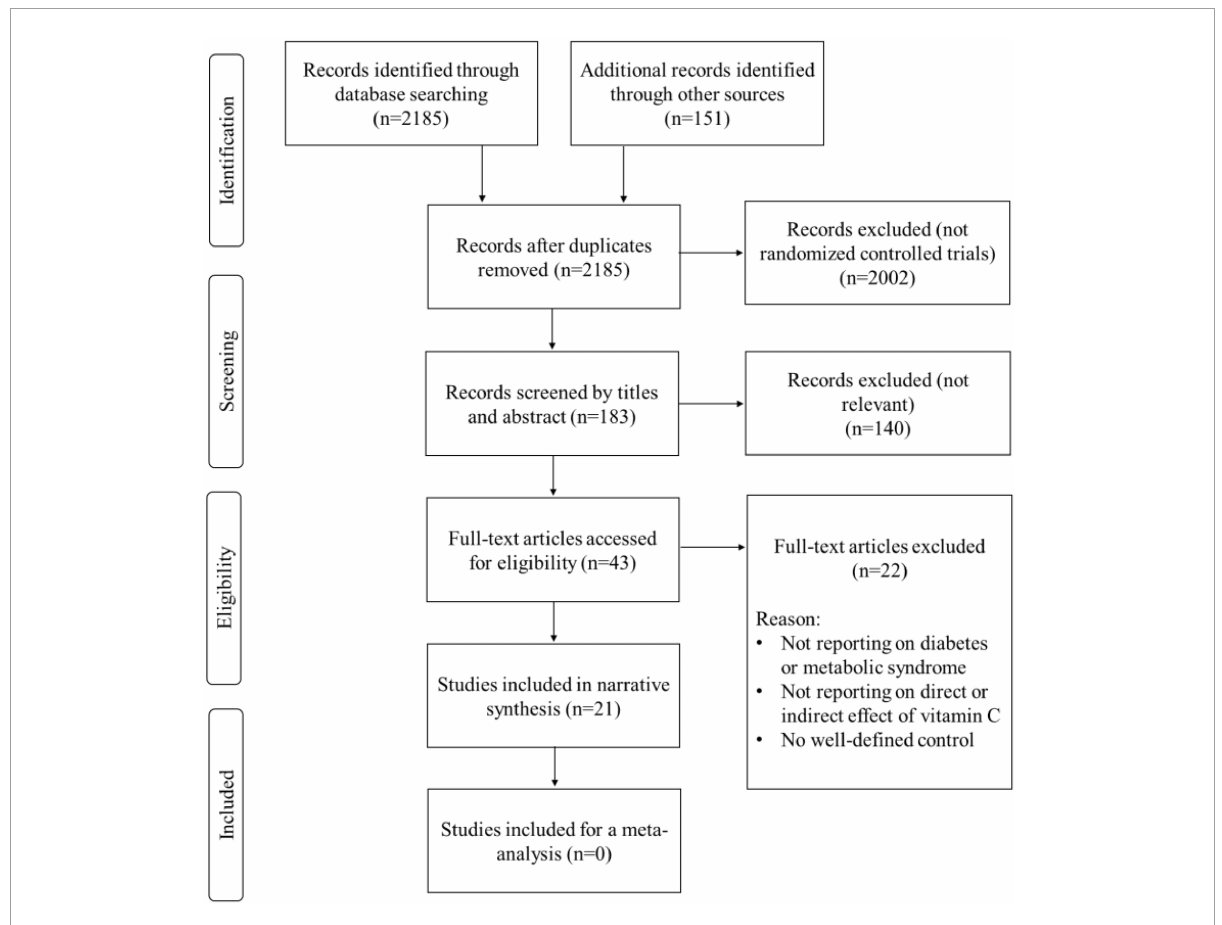
FIGURE2 A summary of flow diagram presenting study